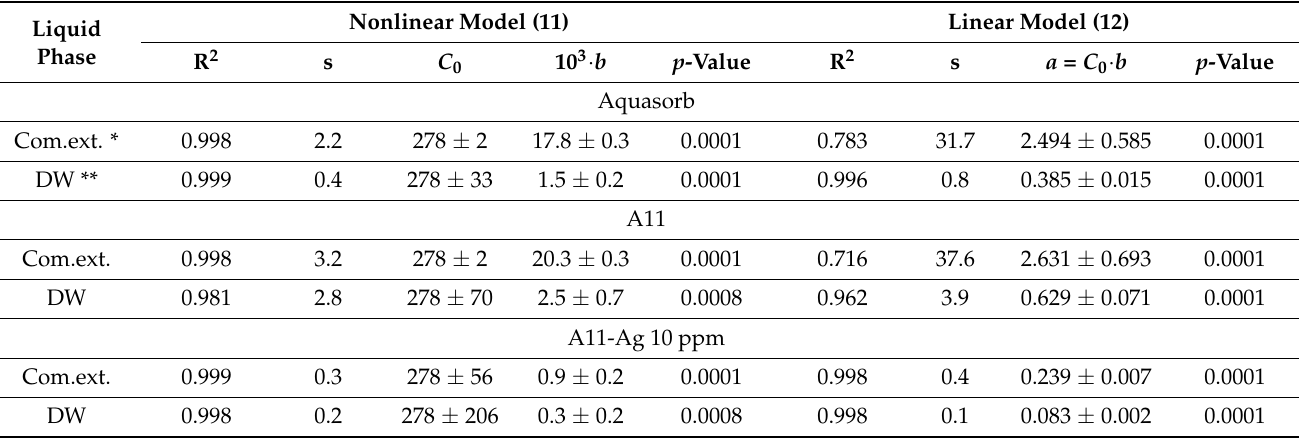
Table 1. Approximation parameters of Models (11) and (12) for standardized BOD